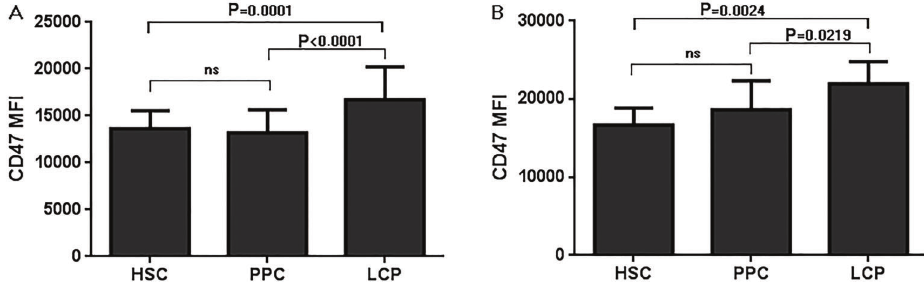
Figure 4. Comparison of CD47 expression among different CD34-positive cell compartments (ANOVA with Bonferroni post-test). Data are reported as mean ± SD. A , Patients with myelo fi brosis; B , Controls; MFI: Mean fl uorescence intensity; HSC: hematopoietic stem cells; PPC: pluripotential progenitor cells; LCP: lineage committed progenitors; ns: non-signi fi